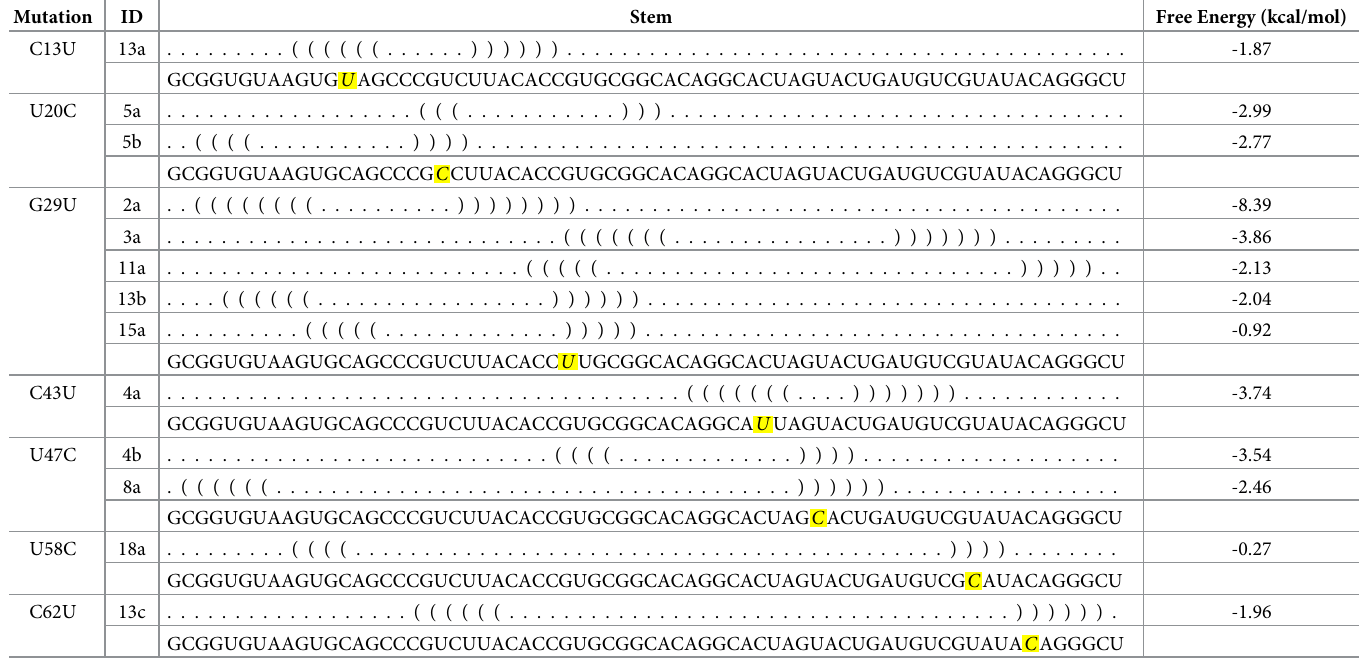
Table 8. Predicted initial stems for mutated SARS-CoV-2 − 1 PRF stimulating pseudoknot sequences. These stems were used as structural constraint for predicting the secondary structure of mutated SARS-CoV-2 − 1 PRF sequences. First column identifies the mutation and its location in the 68 nt − 1 PRF sequence. For example C13U identifies a mutation from C to U at index 13. Second column provides the stem ID based on the stem’s free energy and the ranking of the initial stem of the reference sequence. For example, in row 1 the stem has a free energy of − 1.87 kcal/mol and is denoted by stem ID 13 a . Relative to the initial stems predicted for the reference sequence (cf. Table 4), this stem has the thirteenth lowest free energy. Third column represents the predicted initial stem for the mutated sequence, and the fourth column provides free energy of the given stem (kcal/mol). Input sequence is provided in the bottom row for each mutation section with mutations highlighted in